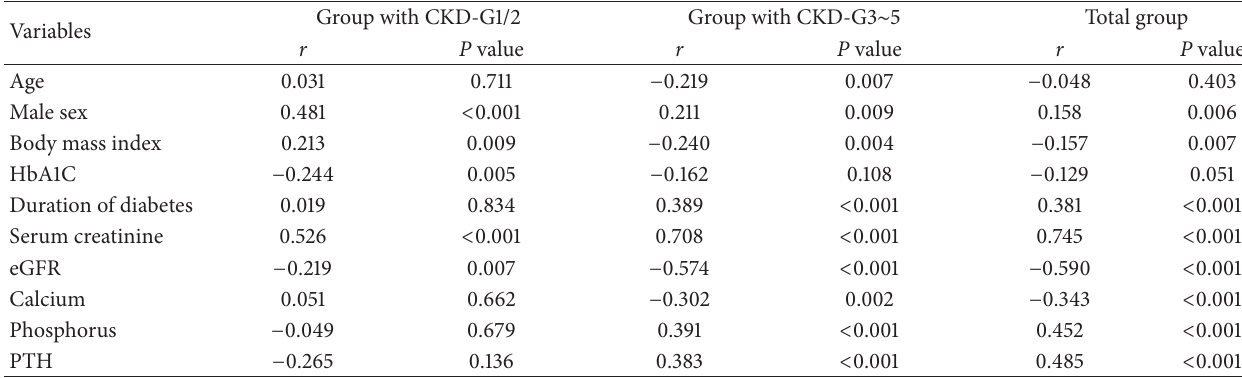
Table 2: Univariate correlations between serum sclerostin level and various parameters.